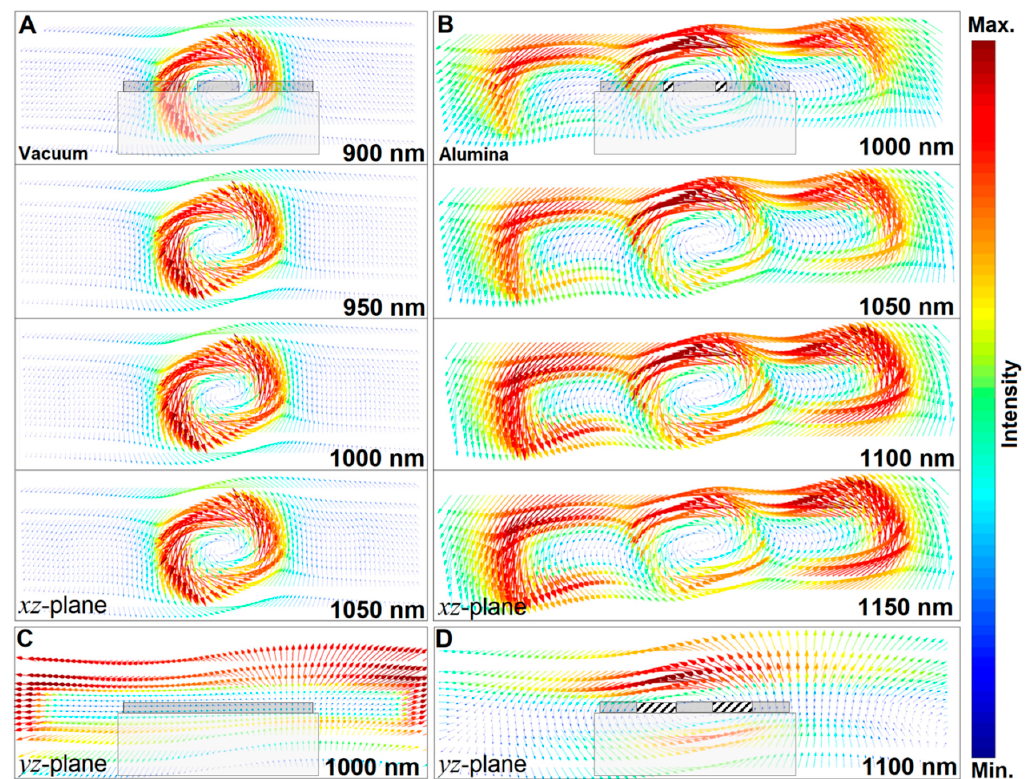
Figure 4. ( A , B ) Vectorial H-field panels for the formation of the 1st order toroidal and super-toroidal features in the xz -planes, respectively. In ( B ) the appeared peripheral loops around the central feature correspond with the first order super toroid. ( C , D ) Vectorial H-field maps in the yz -planes for the possibility of the excitation of the second order super toroid, in vacuum and alumina-filled gap regimes, respectively, showing the absence of the current-loop in the vacuum spacer and formation of the additional loop in the presence of the alumina piece. To explore the influence of the variations in the gaps’ permittivity, one should examine the relation between toroidal currents and dielectric variations [25,26]. To underlay the physics behind